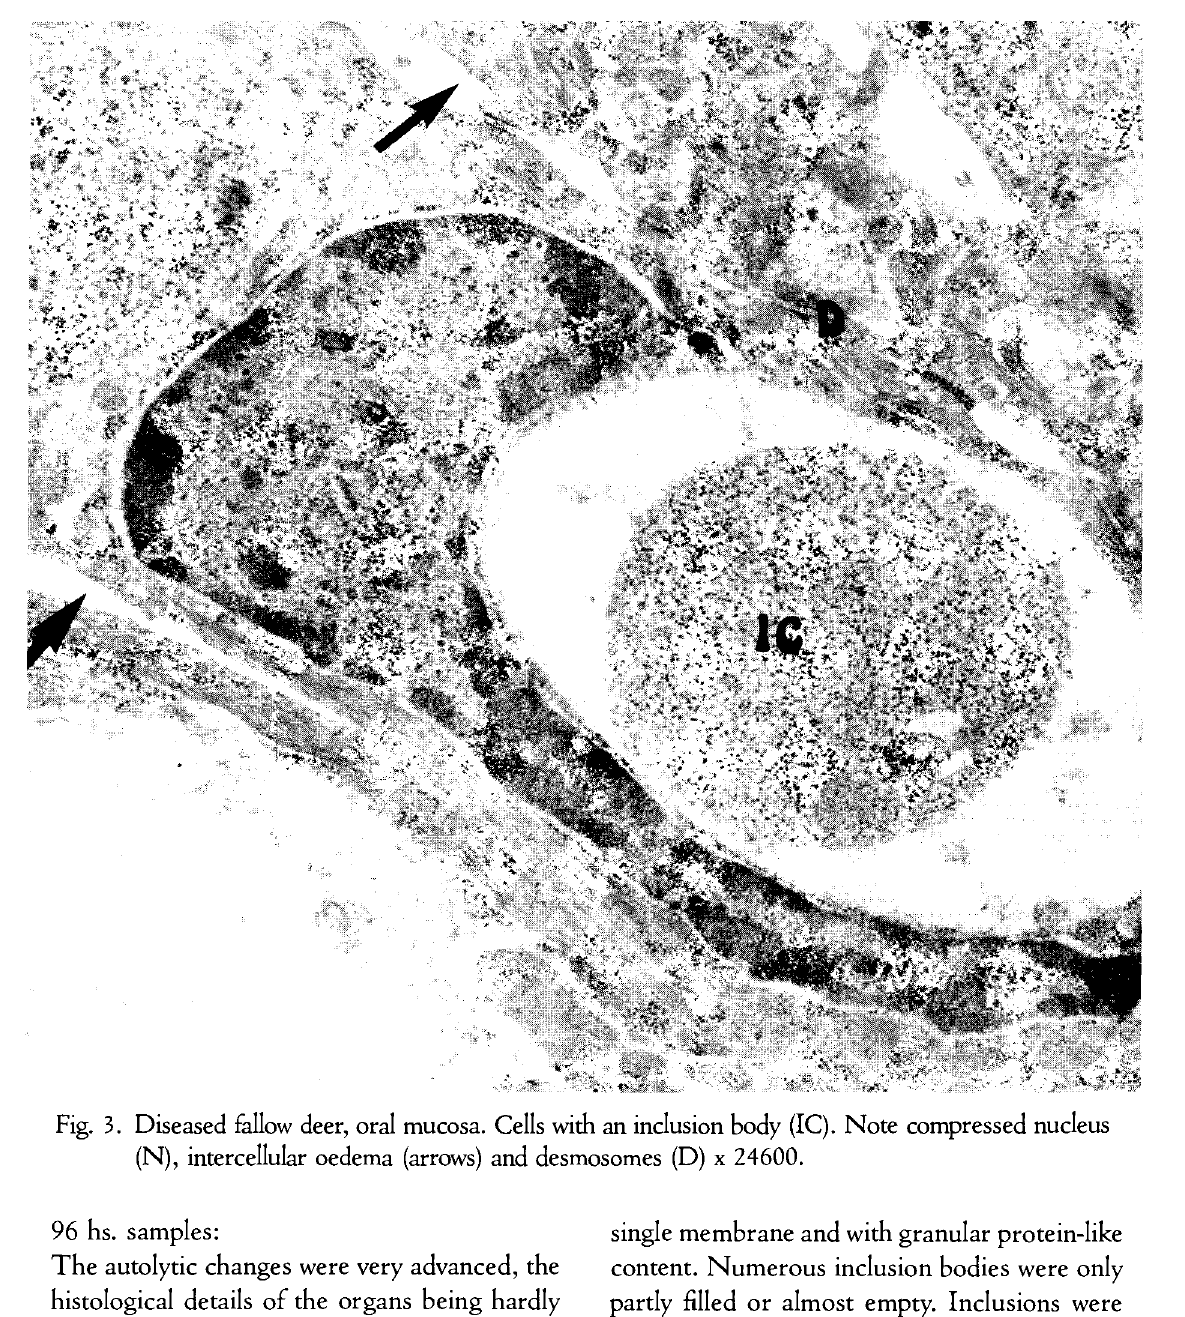
Fig. 3. Diseased fallow deer, oral mucosa. Cells with an inclusion body (IC). Note compressed nucleus (N), intercellular oedema (arrows) and desmosomes (D) x 24600. 96 hs.